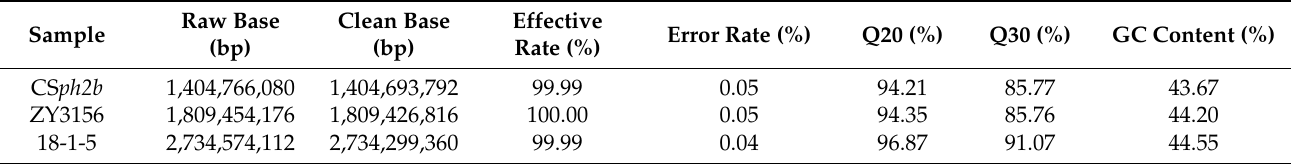
Figure 5. The agronomic traits of the wheat– P. huashanica disomic addition line 18-1-5 and its wheat parents. ( a ) Adult plants; ( b ) spikes; ( c ) spikelets; and ( d ) grains. (1) CS; (2) CS ph2b ; and (3) 18-1-5. Table 1. The agronomic performance of 18-1-5, and its wheat parents CS and CS ph2b. Table 2. Quality of GBS